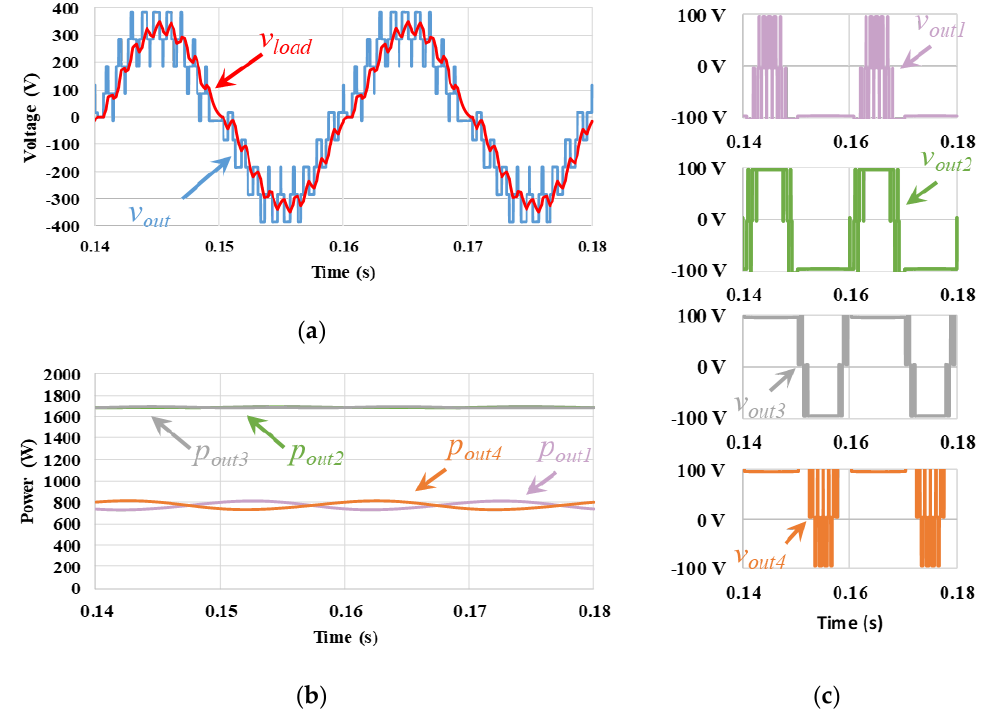
Figure 24. Simulation results of the CO-PD PWM technique: ( a ) output voltage of the cascaded MLC, v out , and load voltage, v load ; ( b ) output power on each submodule ( p out1 , p out2 , p out3 , p out4 ); ( c ) output voltage on each submodule ( v out1 , v out2 , v out3 , v out4 ).